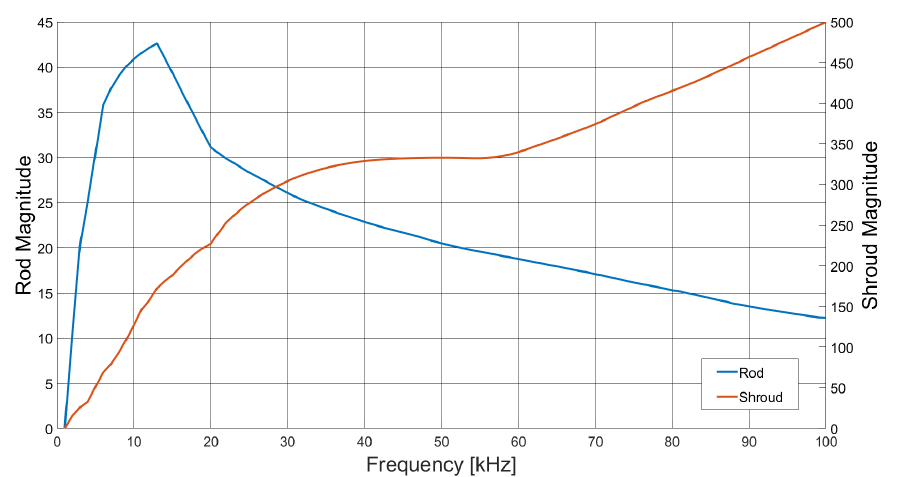
Figure 15. Image maximum as a function of frequency, for the rendered images for both the alu- minium rod sample and the internally-included copper shroud